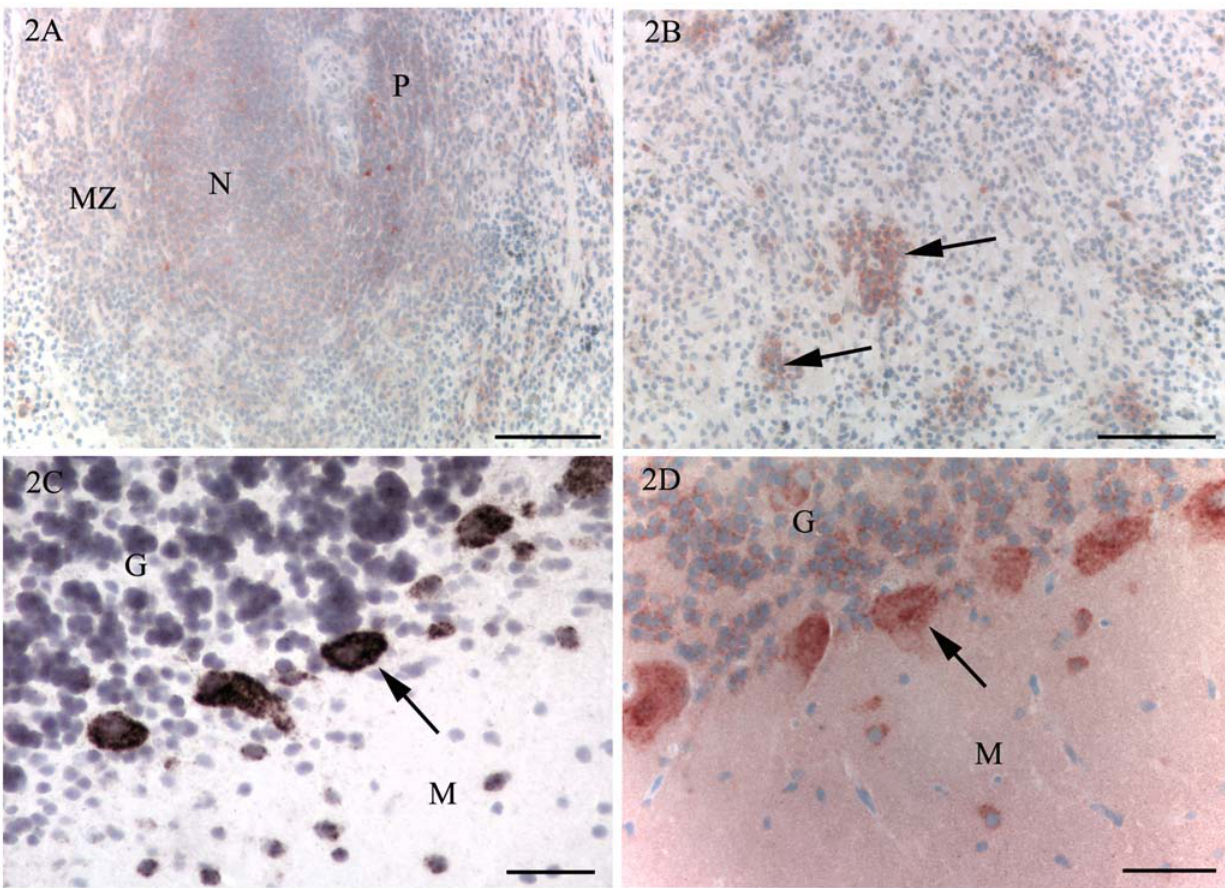
Figure 2. Immunohistochemistry for PrP C (A, B, D) and insitu hybridisation for PrP mRNA (C). A. Spleen of control animal. A weak immunolabelling is present in a lymphoid nodule (N), the marginal zone (MZ) and PALS (P). B. Spleen of control animal. In the red pulp, immunolabelling for PrP C was mainly detected in single cells or small groups of cells (arrows). C, D. To correlate detection of PrP C and PrP mRNA, cerebellum of a normal one month old lamb was examined using immunohistochemistry and in situ hybridisation. C. In situ hybridisation. PrP transcripts were detected in Purkinje cells (arrow) and some scattered cells of the molecular (M) and granule cell (G) layers. D. PrP C immunohistochemistry. There is strong cytoplasmic immunolabelling of Purkinje cells (arrows) and scattered cells of the molecular (M) and granule cell (G) layers. Note the weak diffuse immunolabelling of the molecular layer that is not present with in situ hybridisation (Fig. 2C). Bars, 100 m m (A, B), 50 m m (C, D). Nuclei were stained with